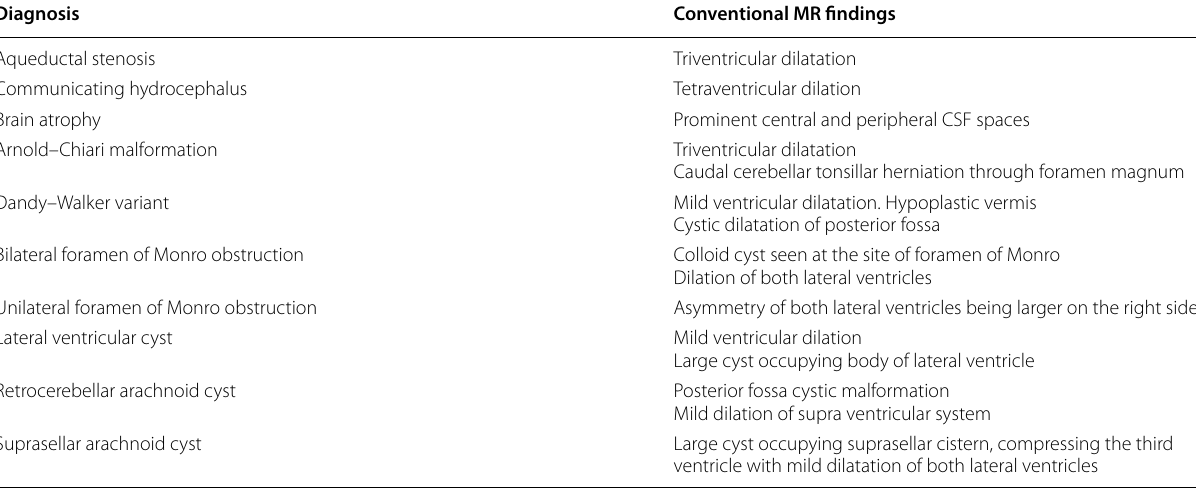
Table 2 Conventional MRI findings in the patients